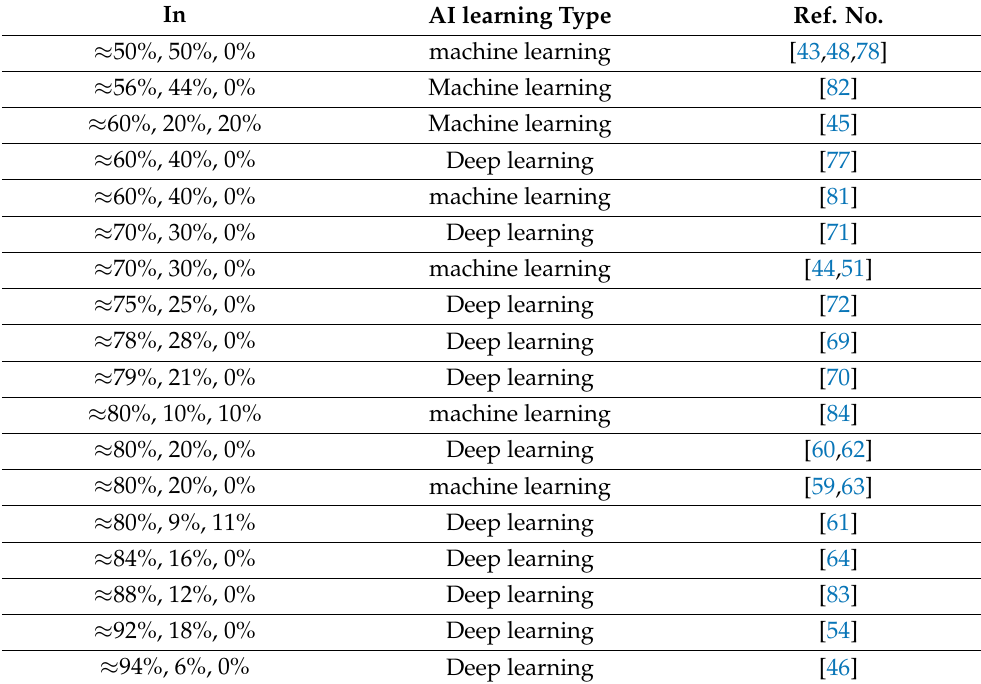
Table 4. Data splitting